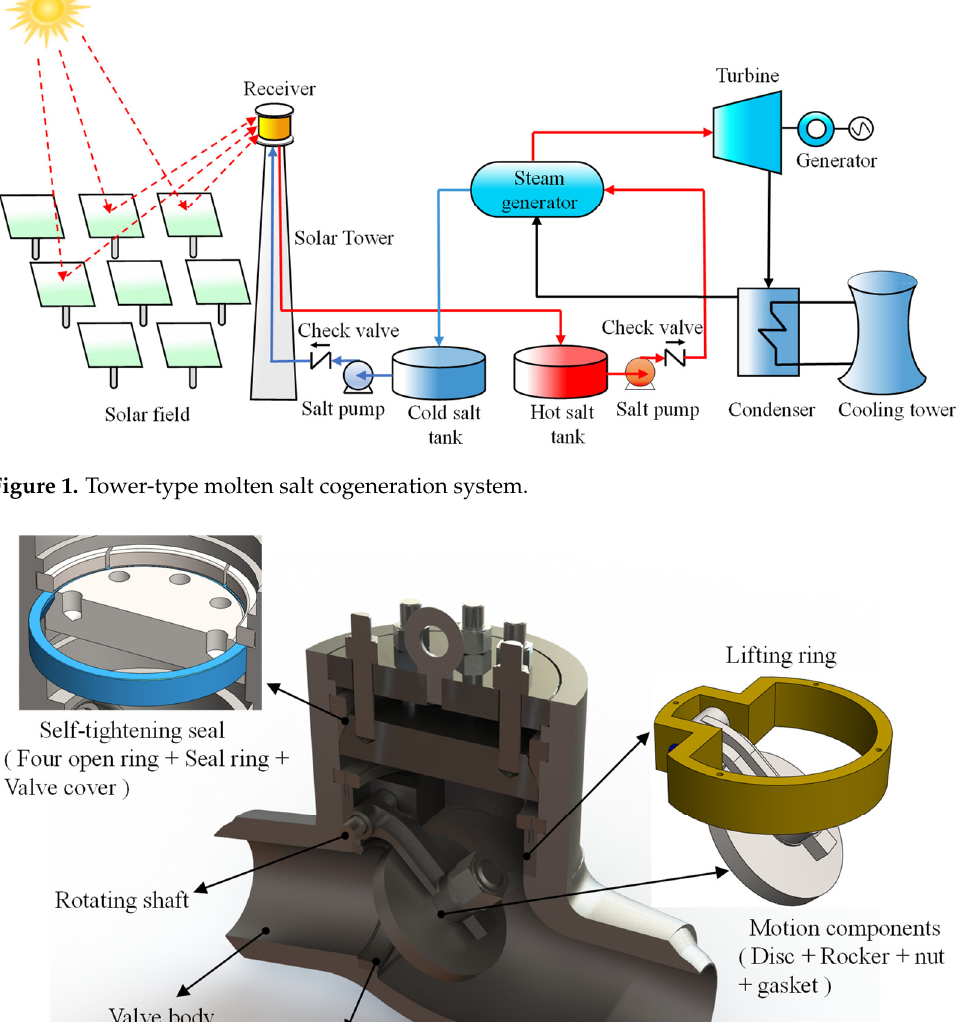
Figure 3. Force analysis of valve motion components. When the molten salt medium flows through the check valve, the disc rotates about the rotating shaft under the action of the resultant force or is in a state of equilibrium. The main torque affecting disc rotation are torque by jet impingement on the disc and the torque by pressure difference, gravity moment, buoyancy moment, and friction moment,